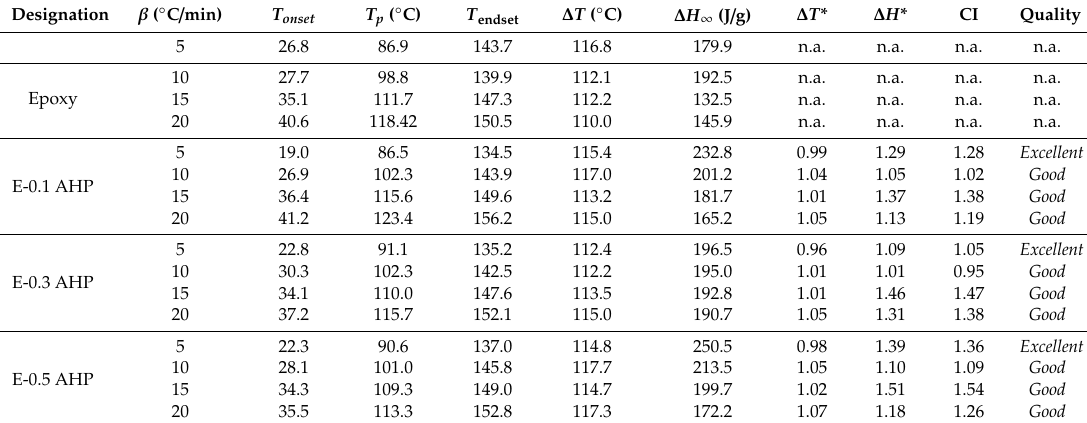
Figure 3. Nonisothermal DSC thermograms of epoxy and epoxy / AHP nanocomposites at heating rates of: ( a ) 5, ( b ) 10, ( c ) 15 and ( d ) 20 ◦ C · min − 1 . Table 1. Cure characteristics of epoxy and its nanocomposites as a function of heating rate ( β ).